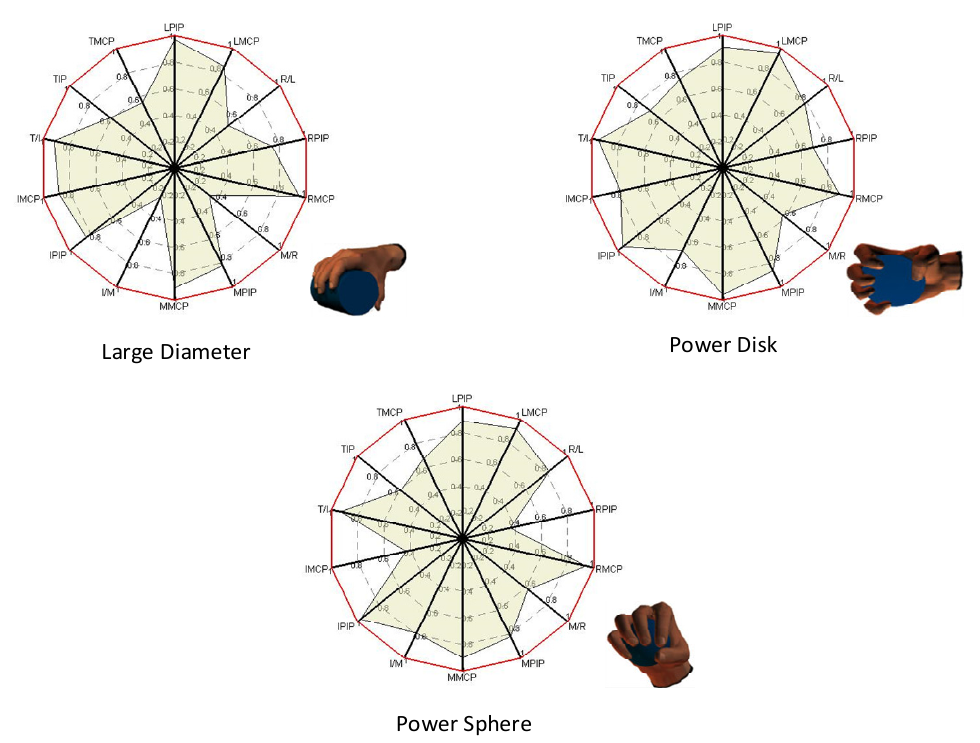
Figure 6. Hand motion reconstruction based on extracted postural synergy basis.